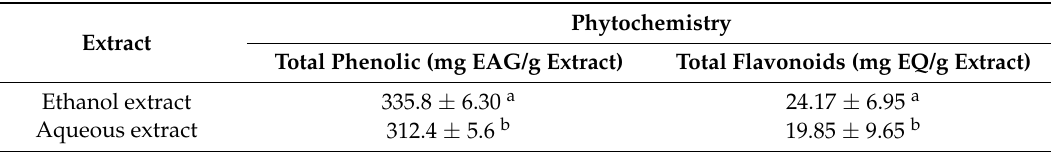
Table 3. Results of total phenolics and total